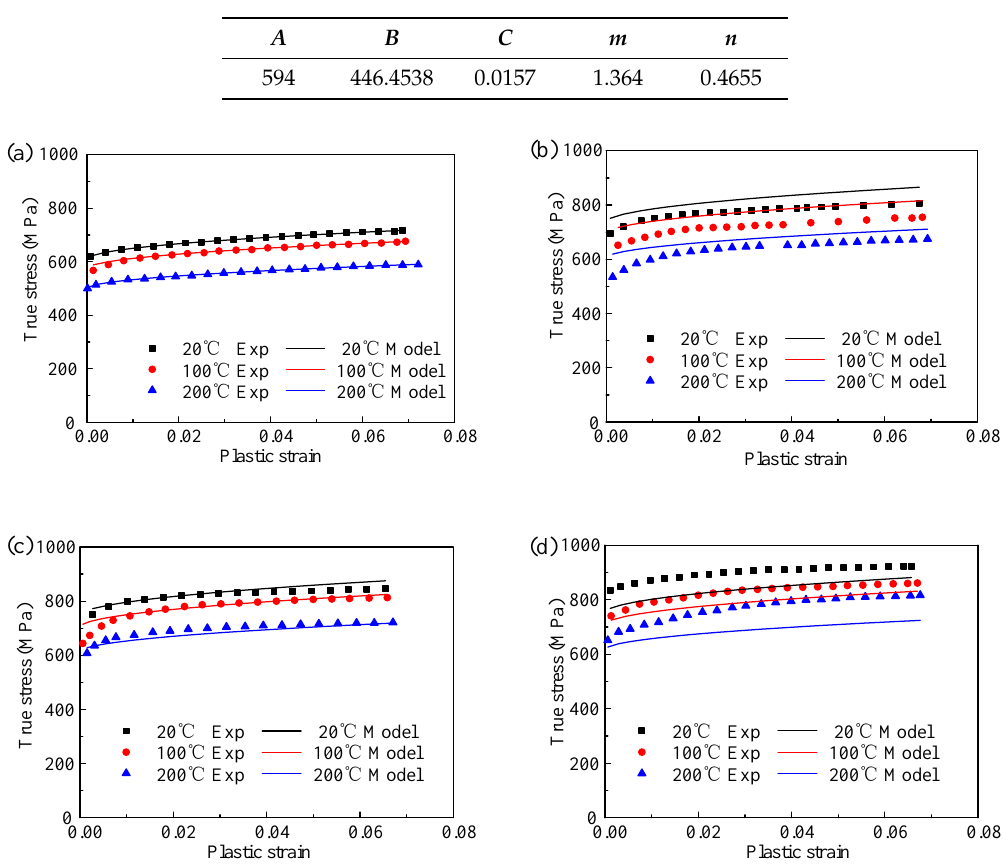
Figure 5. Comparison between experiment result and the predicted flow stress by JC model at di ff erent strain rate of ( a ) 0.001 s − 1 , ( b )1000 s − 1 , ( c ) 3000 s − 1 , and ( d ) 5000 s − 1